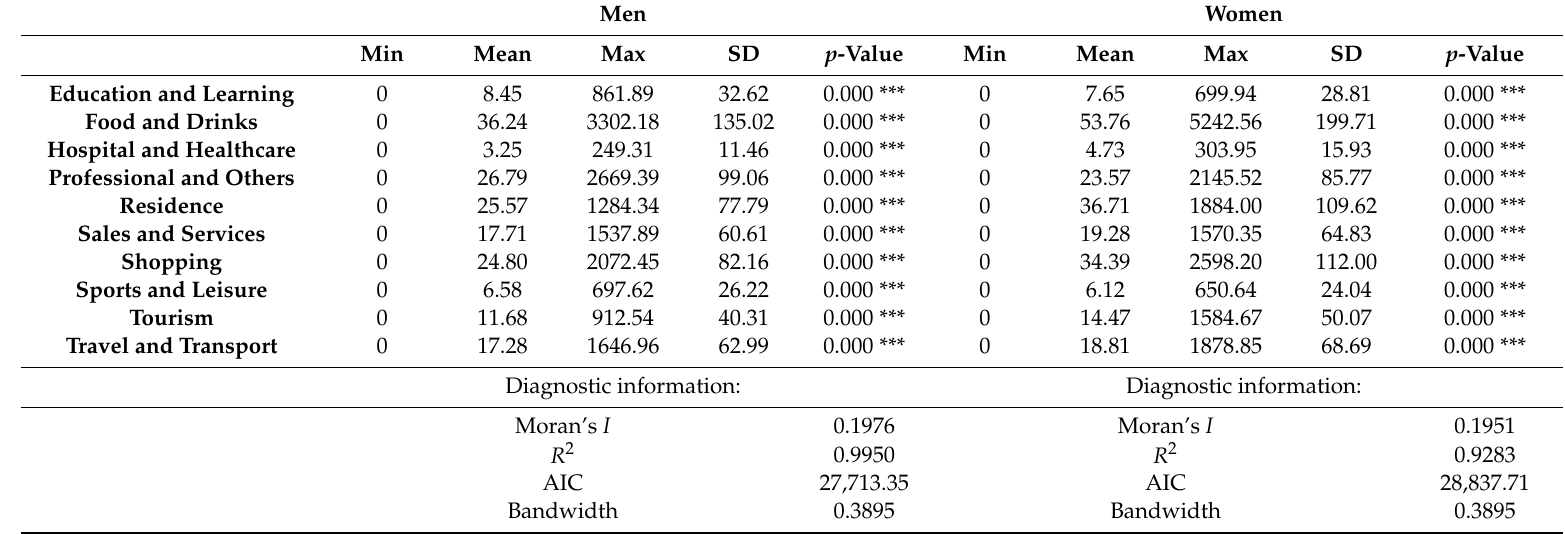
Table 4. Estimated GWR parameters of activities for men and women in